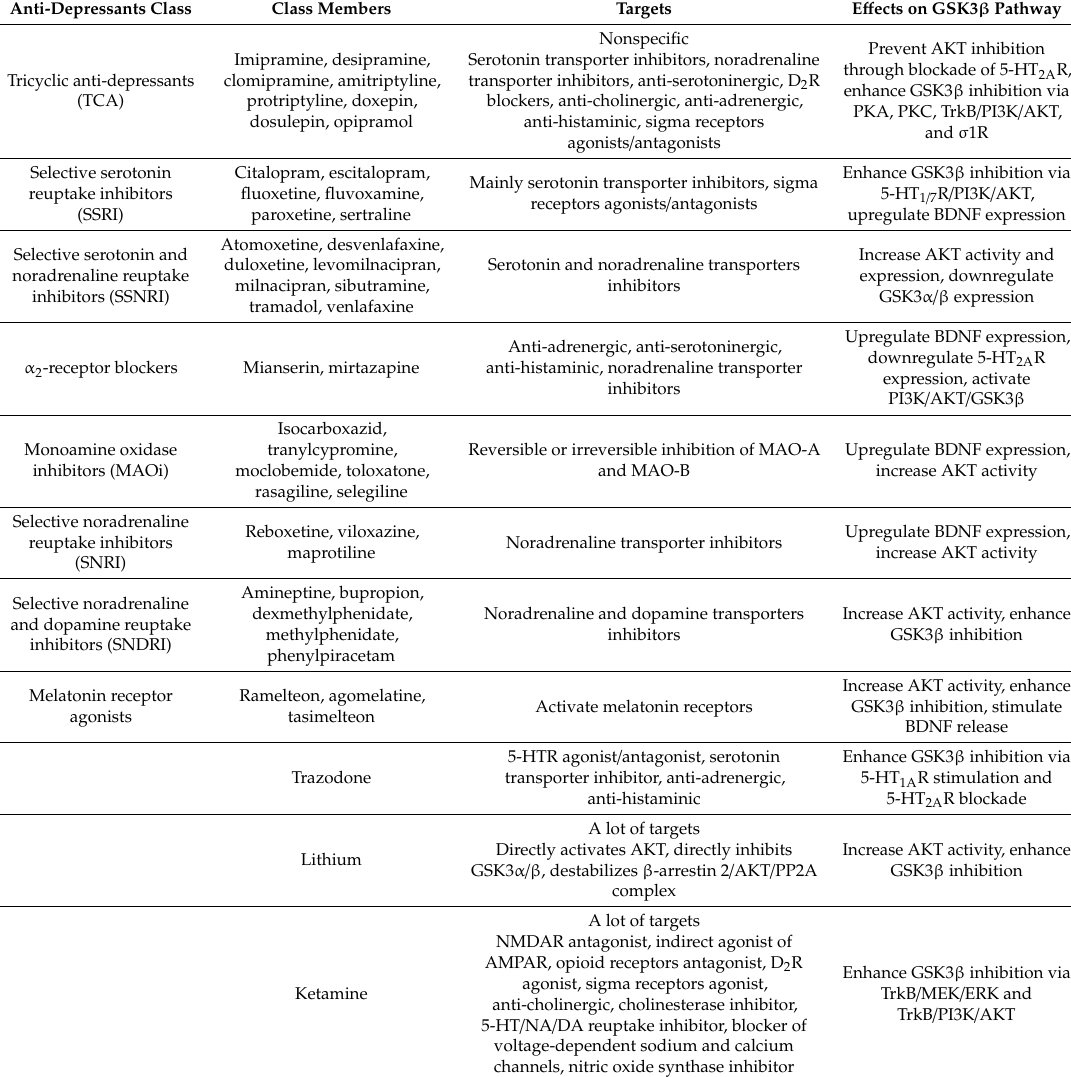
Table 1. Main classes of medications currently used in major depressive disorder (MDD) treatment, with examples of their members and targets of their action. Trazodone, ketamine, and lithium do not belong to any of the listed